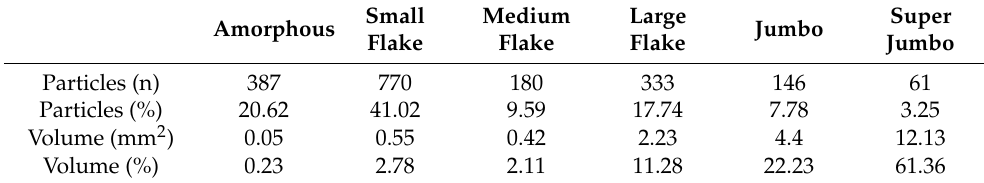
Table 5. Properties of the graphite classes determined.